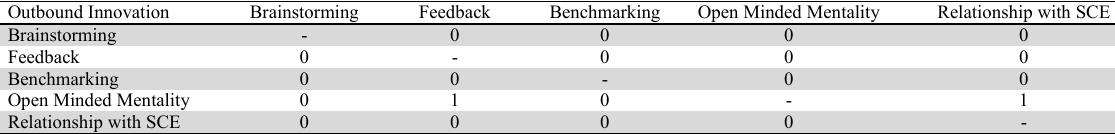
Discordance matrix for the criterion outbound innovation Outbound Innovation